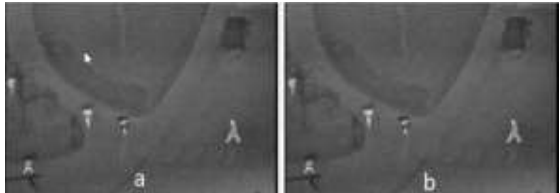
Figure 7. A sample of thermal image (a) and normalized thermal image (b).